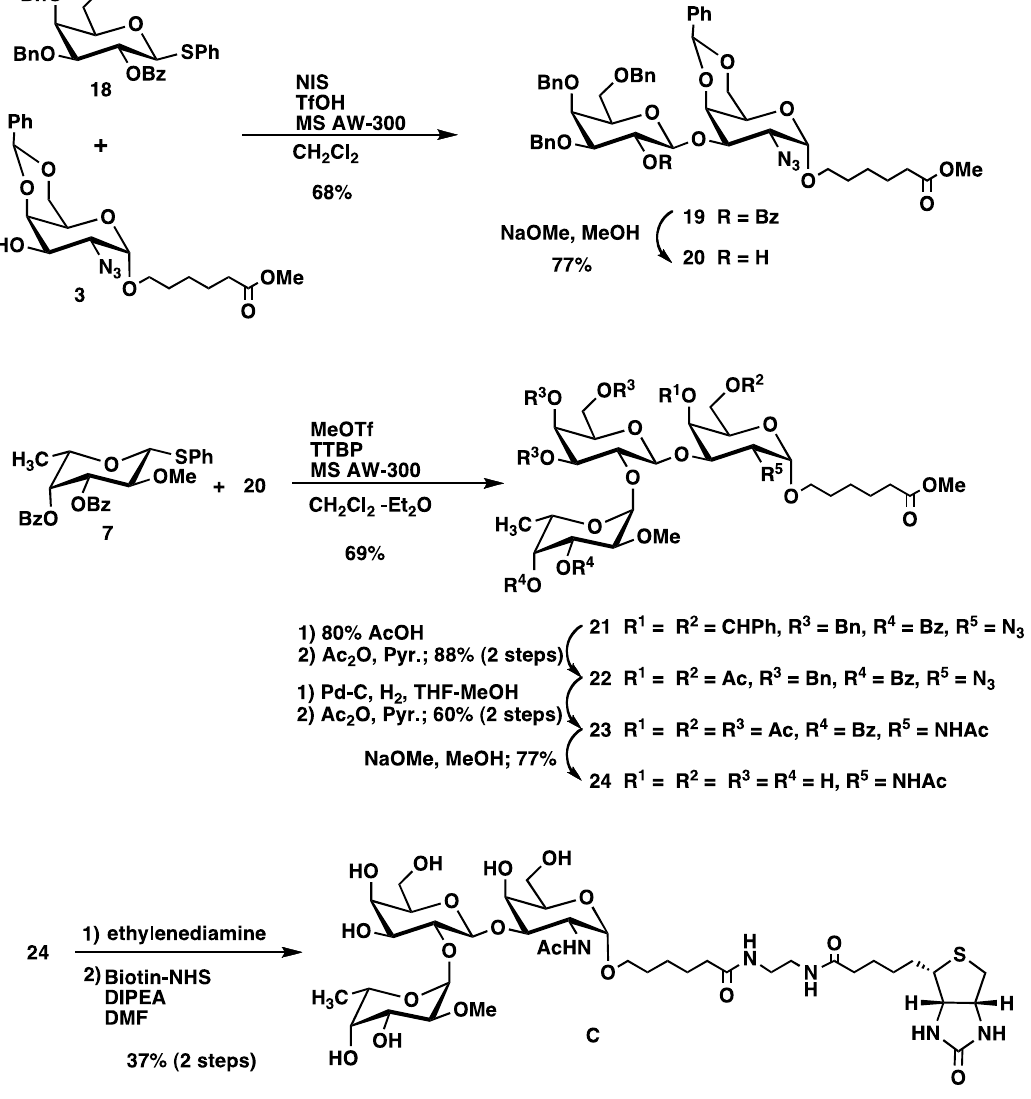
Scheme 3. Synthesis of mono-methylated trisaccharide C